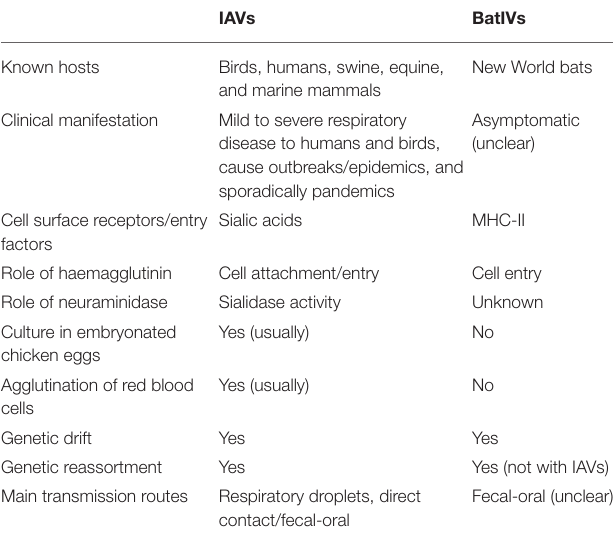
TABLE 1 | List of distinctive features of IAVs and